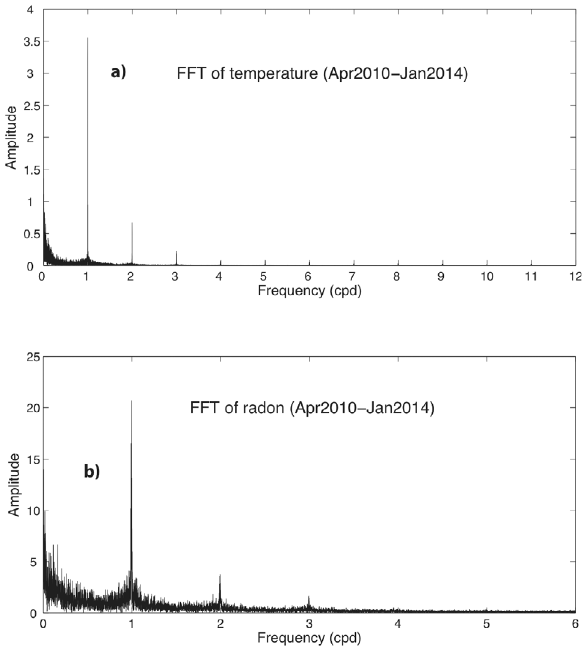
Figure 4. (a): FFT amplitude spectrum of the internal temperature (constant sample increment with time interval of 1 hour measured by PTRL station). (b): FFT amplitude spectrum of the radon (con- stant sample increment with time interval of 2 hours measured by PTRL